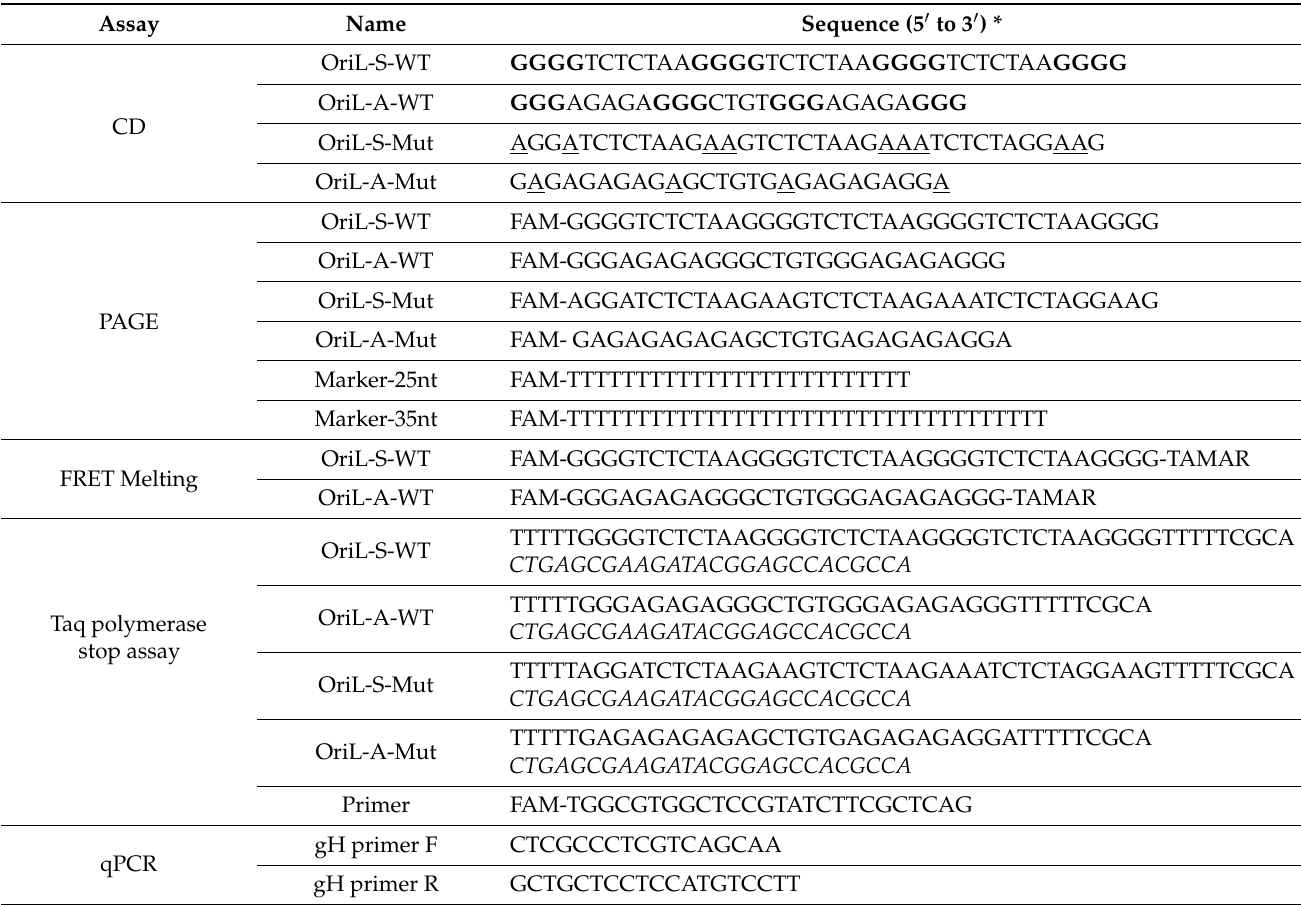
Table 1. Oligonucleotides and primers used in this